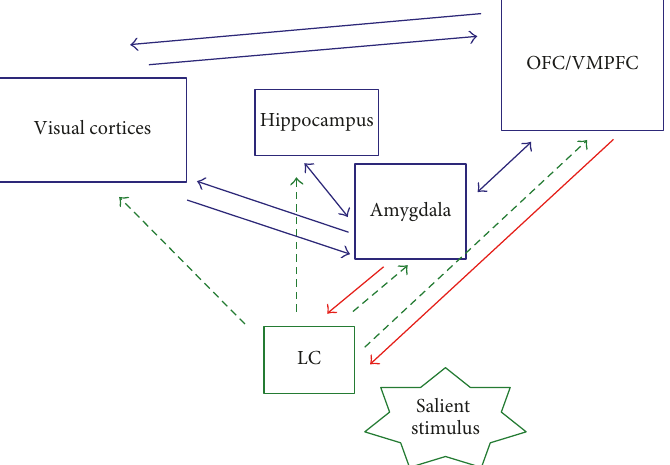
Figure 1: Key pathways emphasized by the biased attention by norepinephrine (BANE) model: green dashed lines indicate noradrenaline (NA) pathways. Red lines indicate projections to the locus coeruleus (LC). Thicker lines indicate direct modulation of visual cortex activity in a ff ect-biased attention. NA activity is implicated in both stimulus-encoding and selective attention [27]. A salient stimulus activates locus coeruleus (LC) neurons, which project widely to cortical and subcortical regions. Adapted with permission from “ Neural and genetic processes underlying a ff ective enhancement of visual perception and memory ” by Markovic et al. [4]. Copyright 2014 by